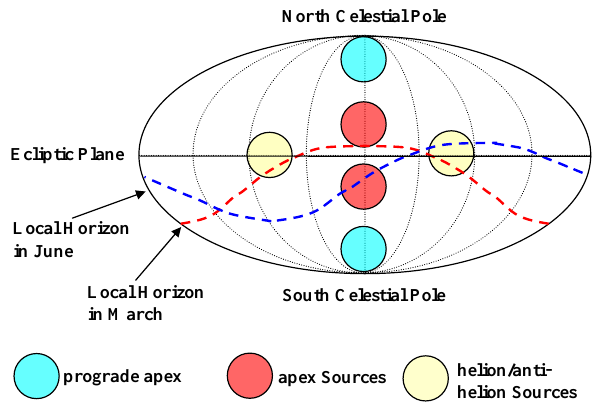
Fig. 7. Schematic of the sporadic sources in the Ecliptic coordinate frame. The helion and anti-helion sources are coloured yellow, The northern and southern apex sources are red and the prograde apex sources are coloured blue. The local horizon at Esrange in March is denoted by the red dotted line, and the local horizon in June–July is denoted by the blue dotted